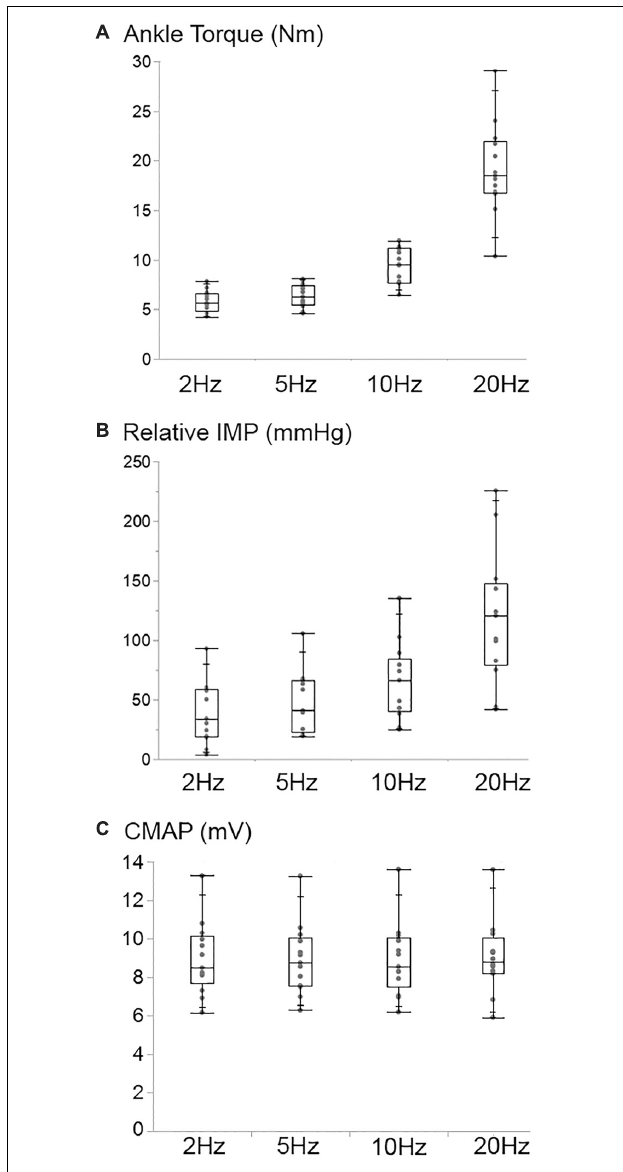
FIGURE 7 | Box and whisker plot of the ankle torque (A) , the intramuscular pressure (Relative IMP) (B) , and the CMAP (C) values at different stimulation frequencies. The TA CMAP did not change ( P = 0.809) whereas the ankle torque ( P < 0.001) and the IMP ( P < 0.001) increased significantly with the increasing stimulation